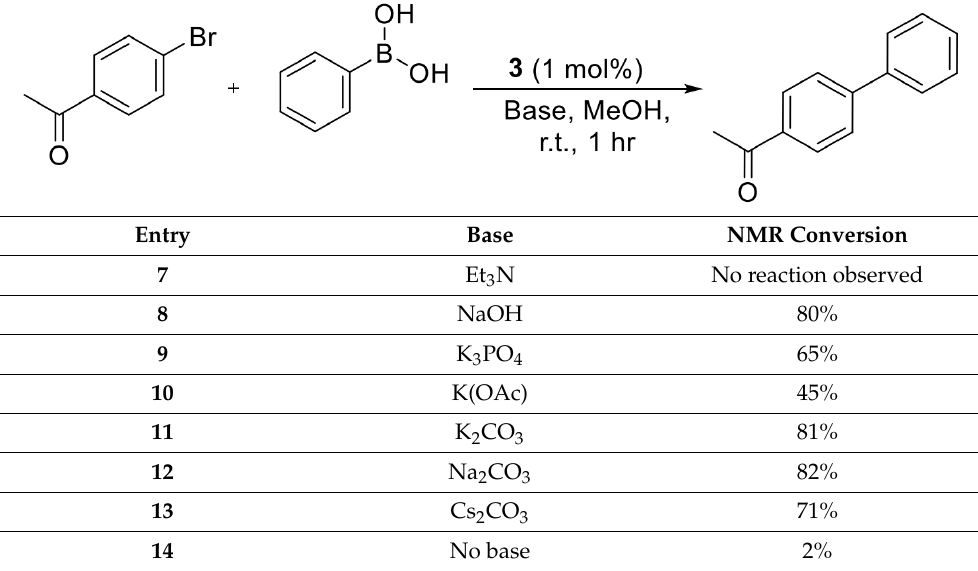
Table 2. Base optimization screen with the range of bases trialled and the NMR spectroscopic conversion obtained.